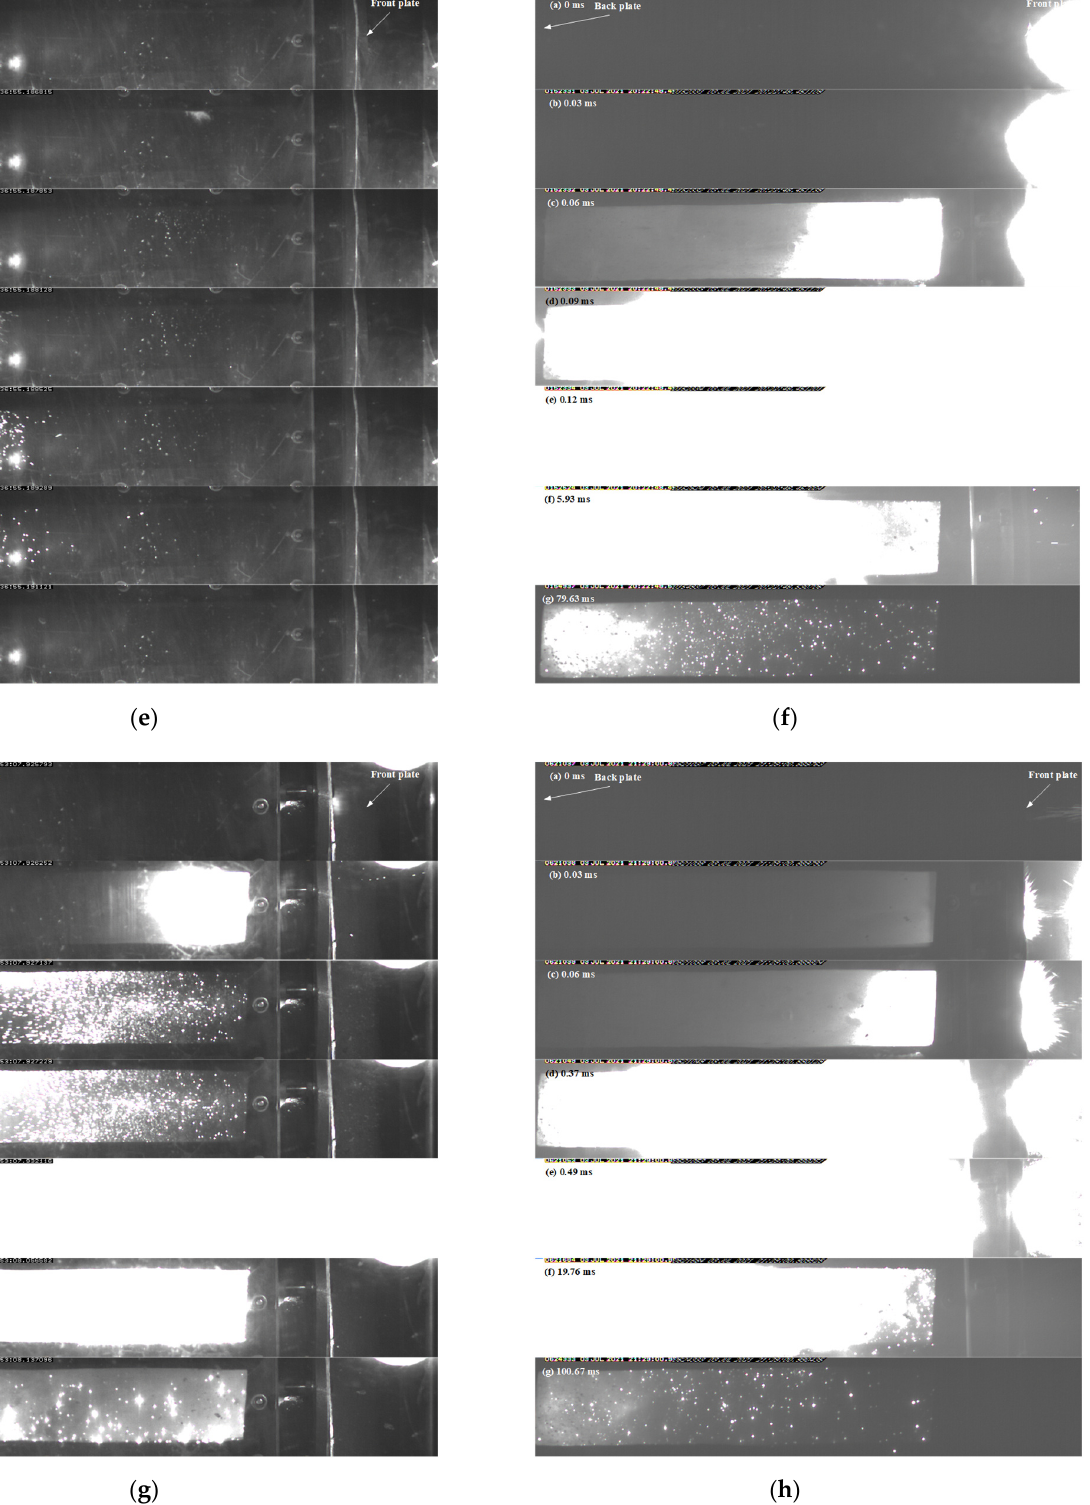
Figure 10. Energy release process of RMs: ( a ) 26.5% Al/73.5% PTFE-635 m/s ( b ) 26.5% Al/73.5% PTFE-1880 m/s ( c ) 5.29% Al/80% W/14.71%PTFE-464 m/s ( d ) 5.29% Al/80% W/14.71% PTFE-1150 m/s ( e ) 62% Hf/38% THV-450 m/s ( f ) 62% Hf/38% THV-1500 m/s ( g ) 88% Hf/12% THV-480 m/s ( h ) 88% Hf/12% THV-1100 m/s.